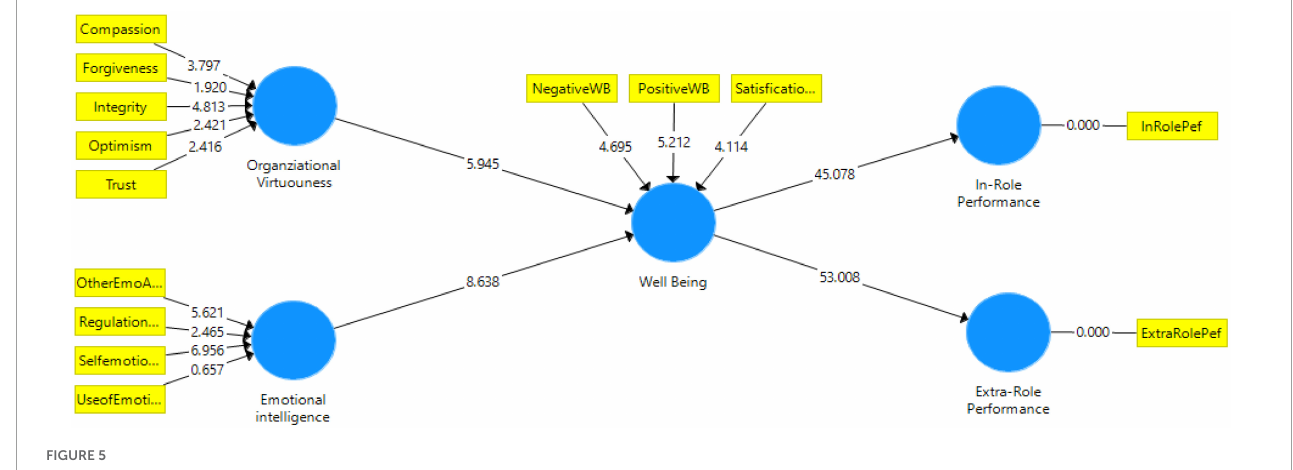
FIGURE5 Structural model assessment.